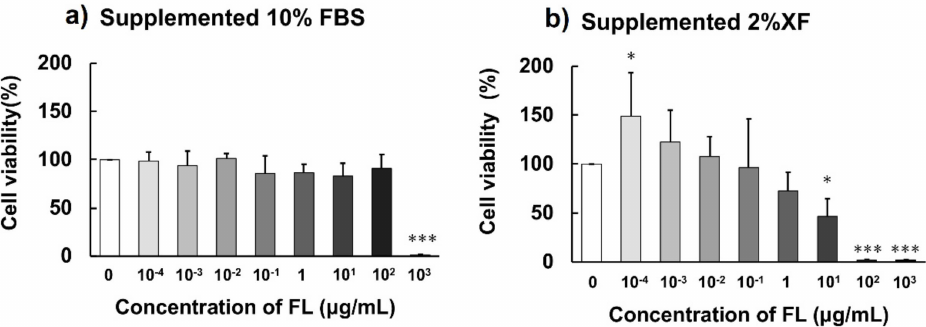
Figure 4. F10 cell viability after 48-h incubation in the presence of di ff erent concentrations of FLs in control culture medium supplemented with 10% fetal bovine serum (FBS) ( a ) or 2% NutriStem V9 XF Basal Medium (XF) ( b ). Each value represents mean ± SD ( n = 5). Significant di ff erences vs. no addition (0 µ g / mL): * p < 0.05, *** p < 0.001.